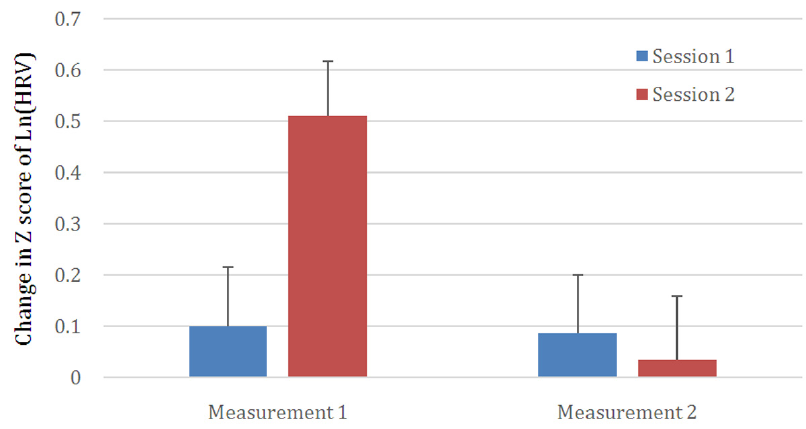
Figure 1. Changes in Z scores of Ln(HRV) (Ln for Napierian Logarithm) for the first and last sessions (“session”) of the therapy and within-session between the first 5 minutes (Measurement 1) and the last 5 minutes (Measurement 1) of a given session.* Depicts statistically significant differences (p < 0.05). Significant changes between measurements 1 and 2 are observed for session 2 but not for session 1. See results for more details.